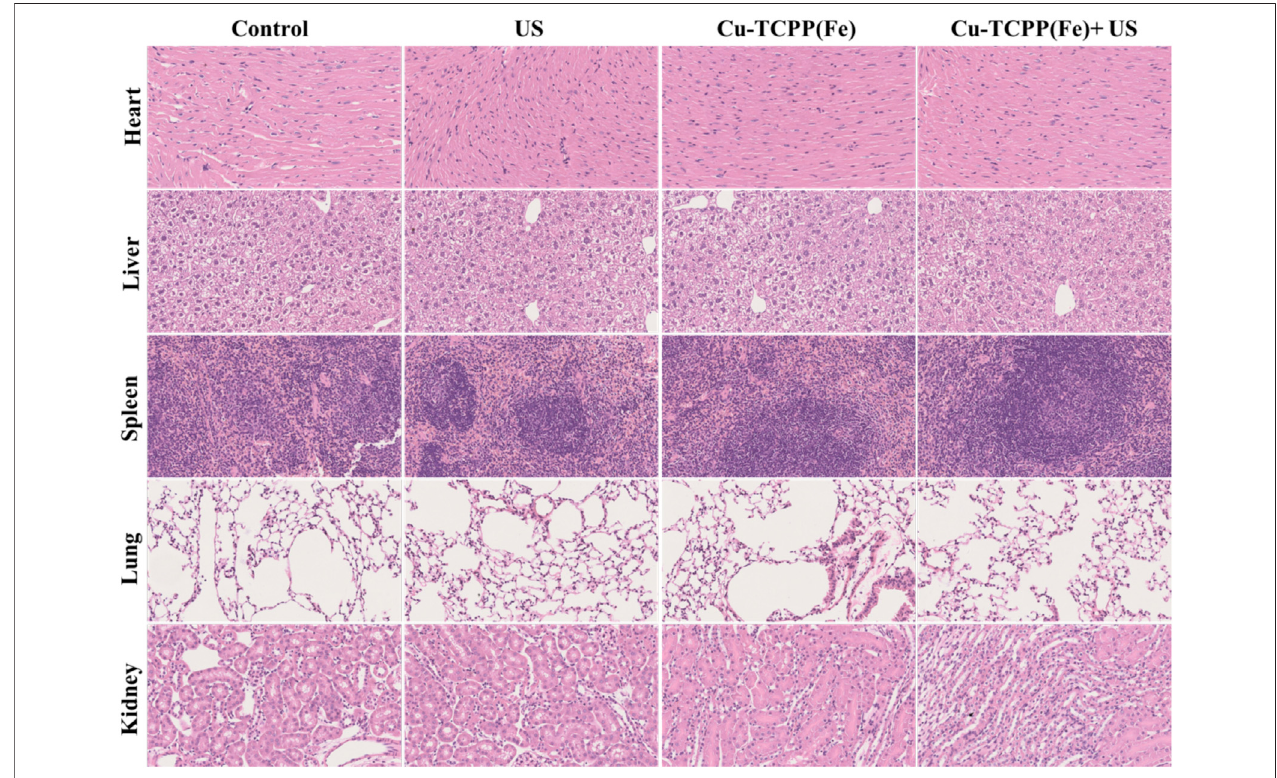
FIGURE 8 | Histopathological examinations of major organs (heart, liver, spleen, lung, and kidney) from mice after different treatments. Scale bar: 50 μ m.